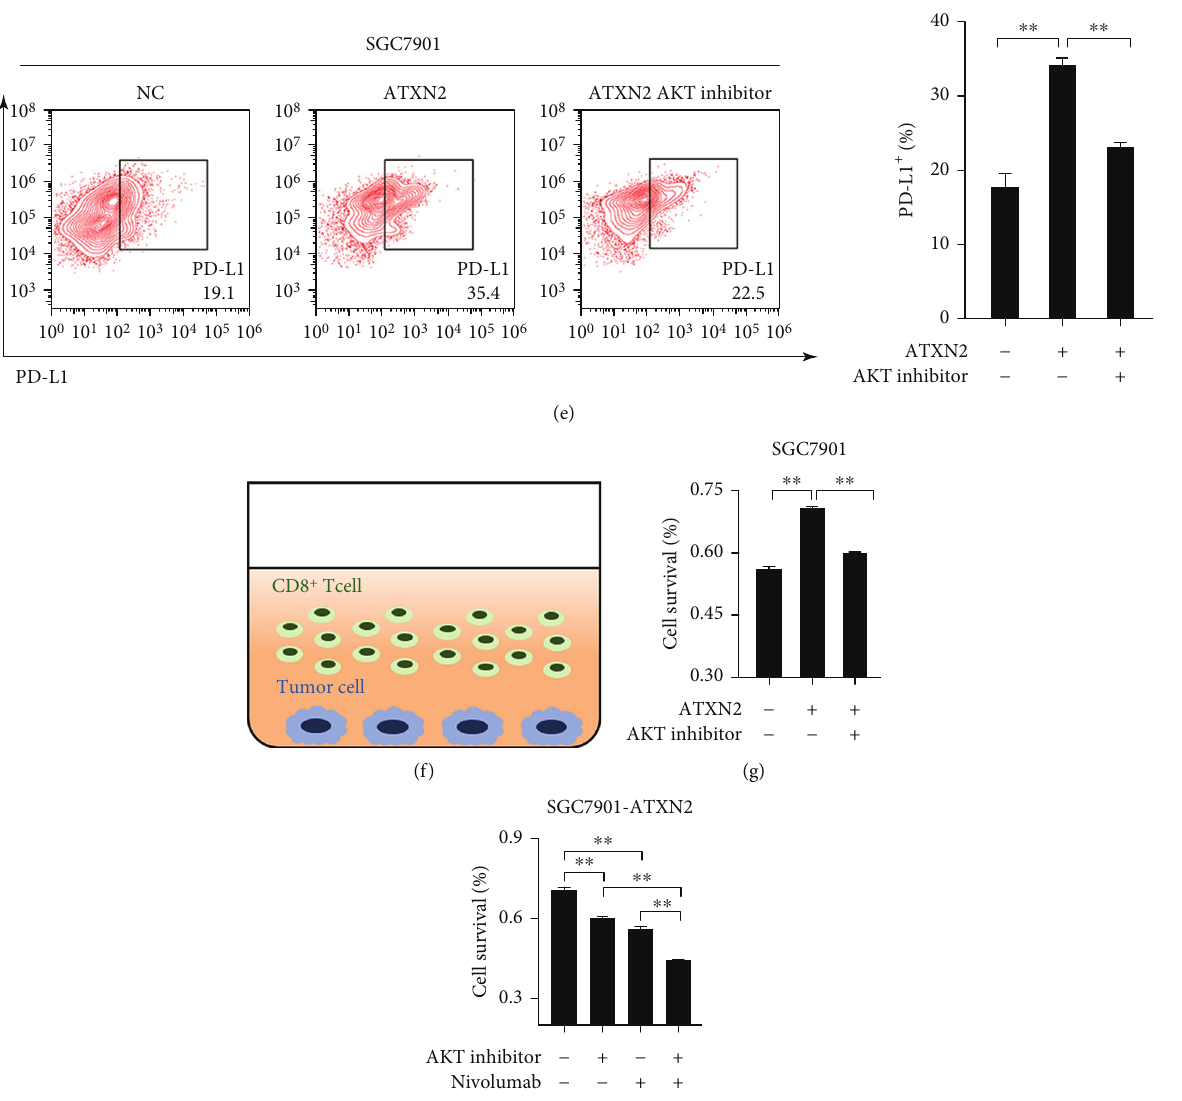
Figure 4: ATXN2 increased the expression of PD-L1. (a) Correlation analysis of ATXN2 expression and immune cell in fi ltration. (b, c) Protein and mRNA levels of PD-L1 in SGC7901 cells (b) and SGC7901/5-FU cells (c). (d) Protein and mRNA levels of PD-L1 in SGC7901 cells overexpressing ATXN2 or treated with an AKT inhibitor. (e) Flow cytometric analysis of PD-L1 expression in SGC7901 cells overexpressing ATXN2 or treated with an AKT inhibitor. (f) Coculture of CD8 + T cells and tumor cells. (g) ATXN2 was overexpressed in SGC7901 cells treated with an AKT inhibitor and cocultured with CD8 + T cells. The survival rates of SGC7901 and SGC7901-ATXN2 cells were measured. (h) SGC7901-overexpressing ATXN2 cells were treated with an AKT inhibitor or nivolumab and cocultured with CD8 + T cells. The survival rate of SGC7901-ATXN2 cells was measured. ∗∗ P < 0 : 01